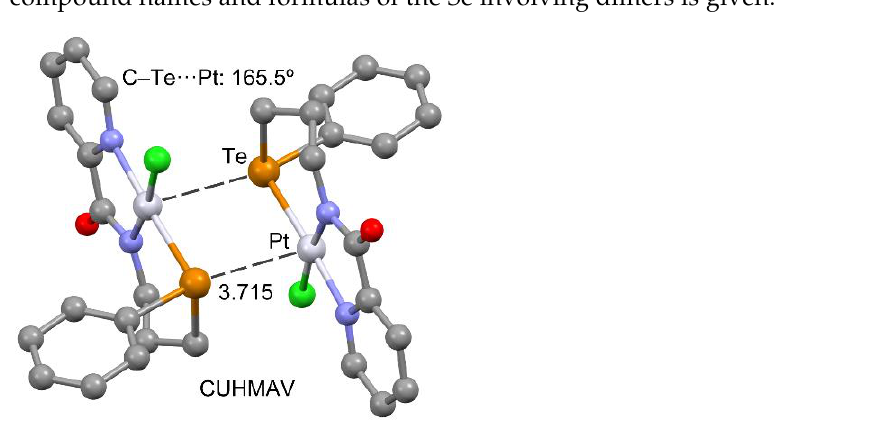
Figure 15. Partial views of the X-ray structures of refcode CUHMAV. Distance in Å. H-atoms omitted for clarity. Table 3. List of CSD codes, compound names and formulas of the Te involving dimers.